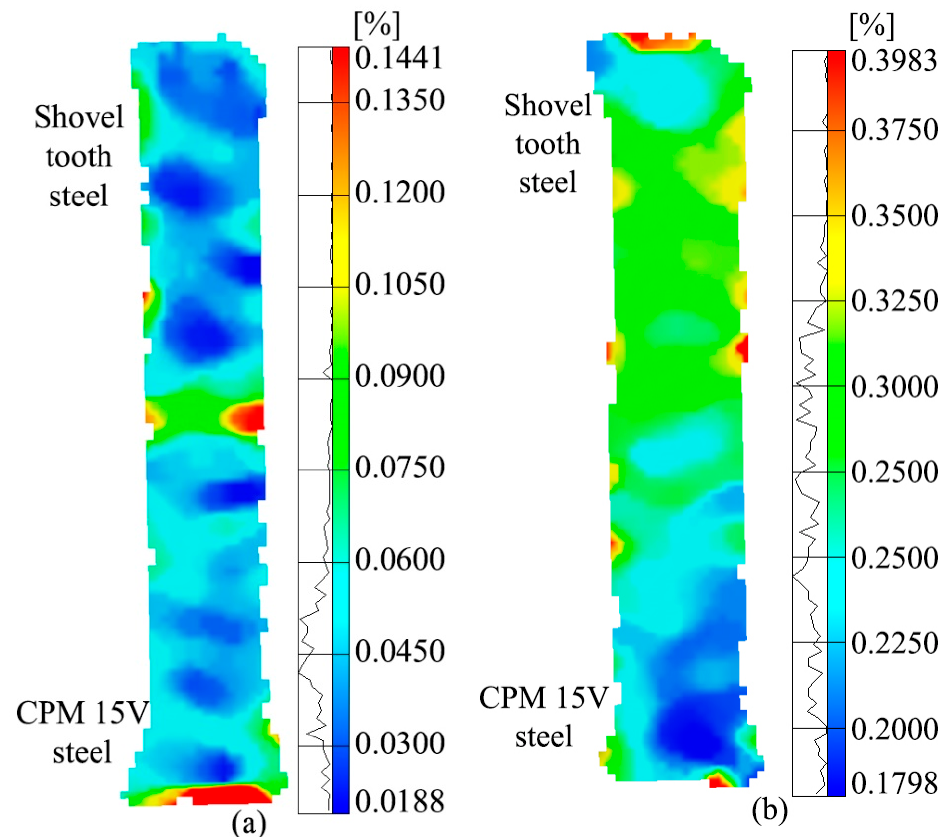
Figure 14. Strain distributions immediately prior to fracture of the LF ( a ) and HF ( b ) welds under tensile loading.